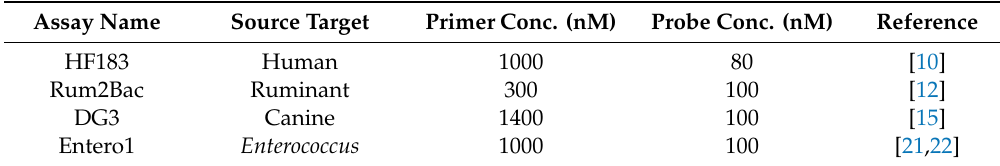
Table 1. Microbial source-tracking assays used in this study. Concentrations for each primer and probes are